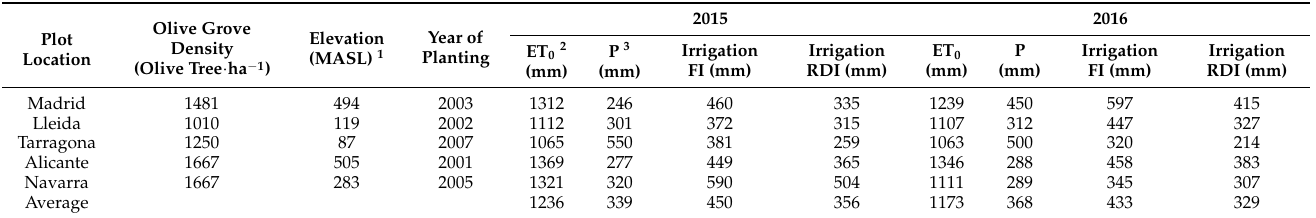
Table 1. Main agroclimatic characteristics of the 5 olive groves and irrigation quantities in each crop season.